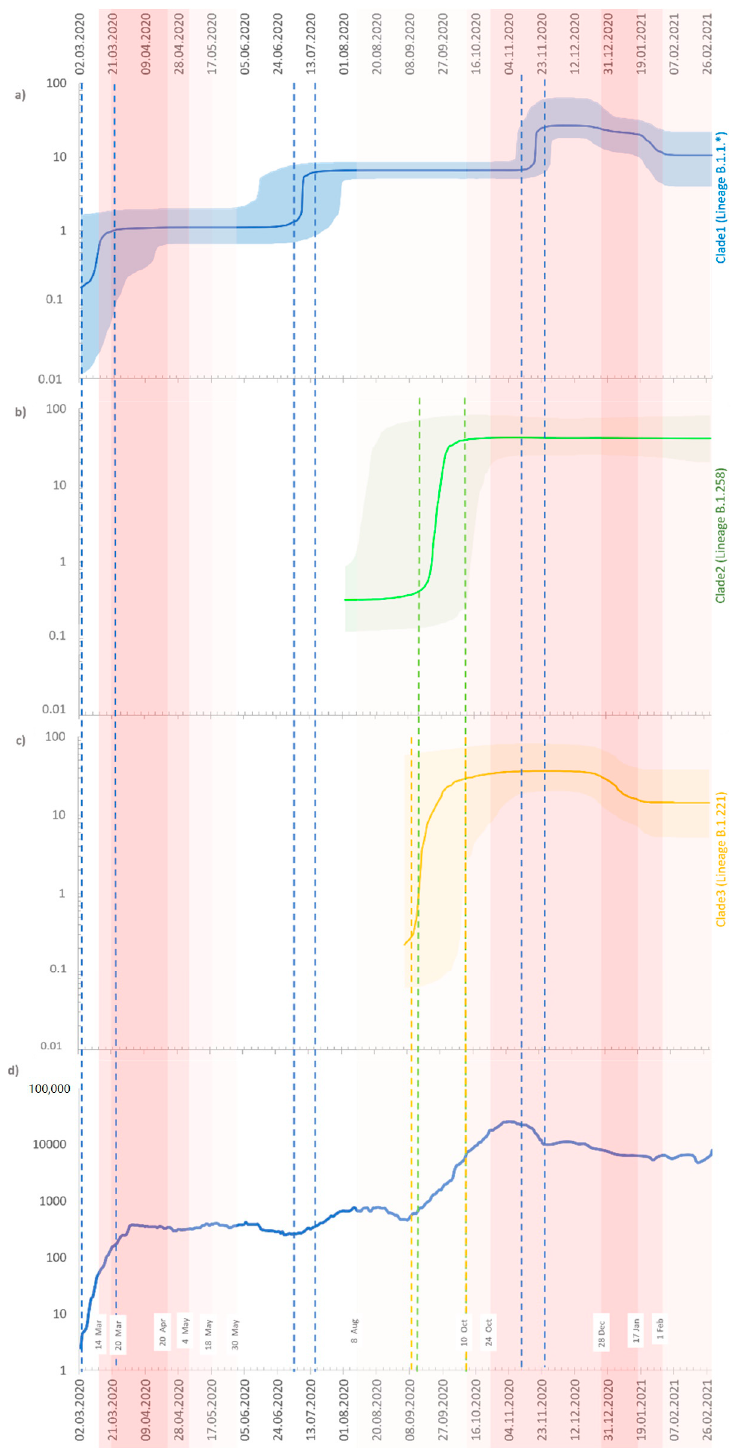
Figure 8. Bayesian skyline plot of the Polish SARS-CoV-2 outbreaks. ( a ) Clade 1 (lineages: B.1.1.*—for details see Supplementary Materials); ( b ) Clade 2 (lineage: B.1.258); ( c ) Clade 3 (lineage: B.1.221); and ( d ) registered cases of COVID-19 in Poland (https://www.gov.pl/web/coronavirus, accessed on 22 June 2021). For ( a – c ), the Y-axis indicates effective population size (N e ), and the X-axis shows the time. The thick solid line represents the median value of the estimates, and the shaded area the 95% HPD (highest posterior density). For ( d ), four different red color intensities exhibit the four-stage restrictive measures implemented by the government at the country level. White rectangles indicate dates of introduction/abolition of the restrictions.